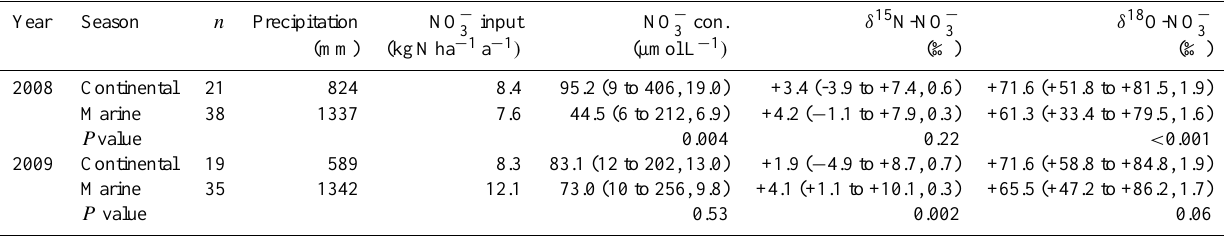
in precipitation. 3